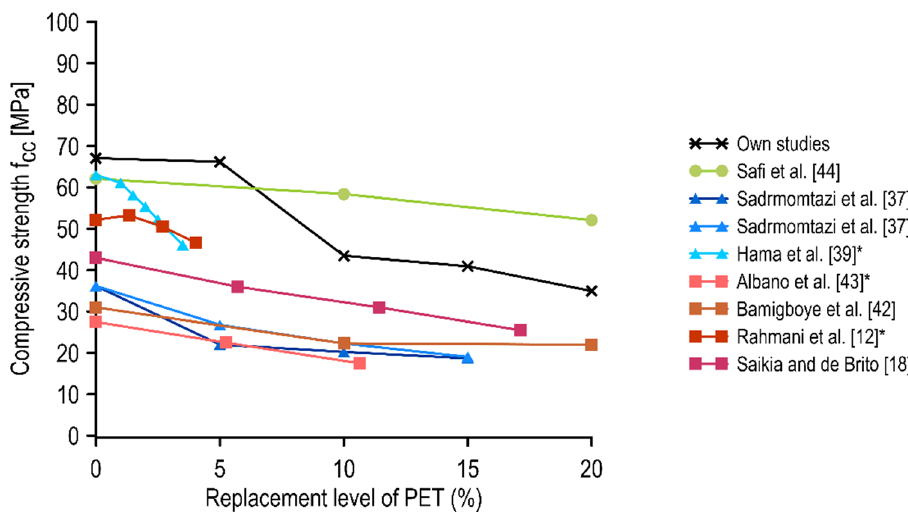
Figure 7. Variations of 28-day compressive strength of different concretes with respect to the replacement level of PET. * Converted from volume replacement.